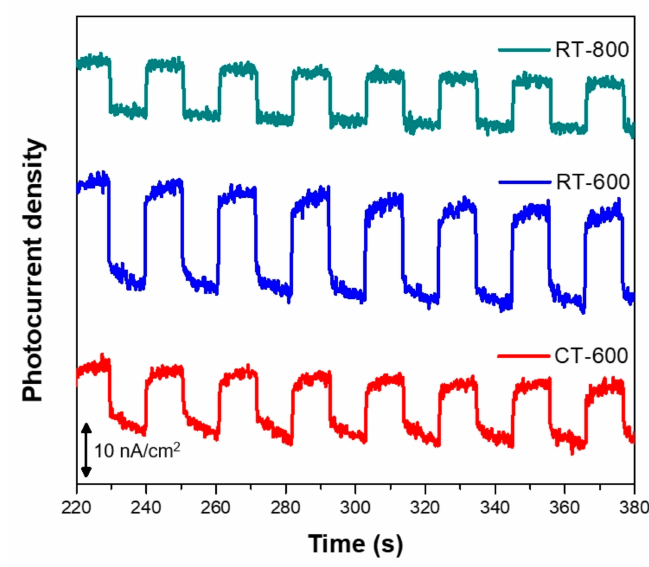
Figure 7. Photoelectrochemical chronoamperometry curves of various TiO 2 samples obtained at 0.6 V vs. Ag / AgCl under solar light illumination with 400 nm cut-o ff